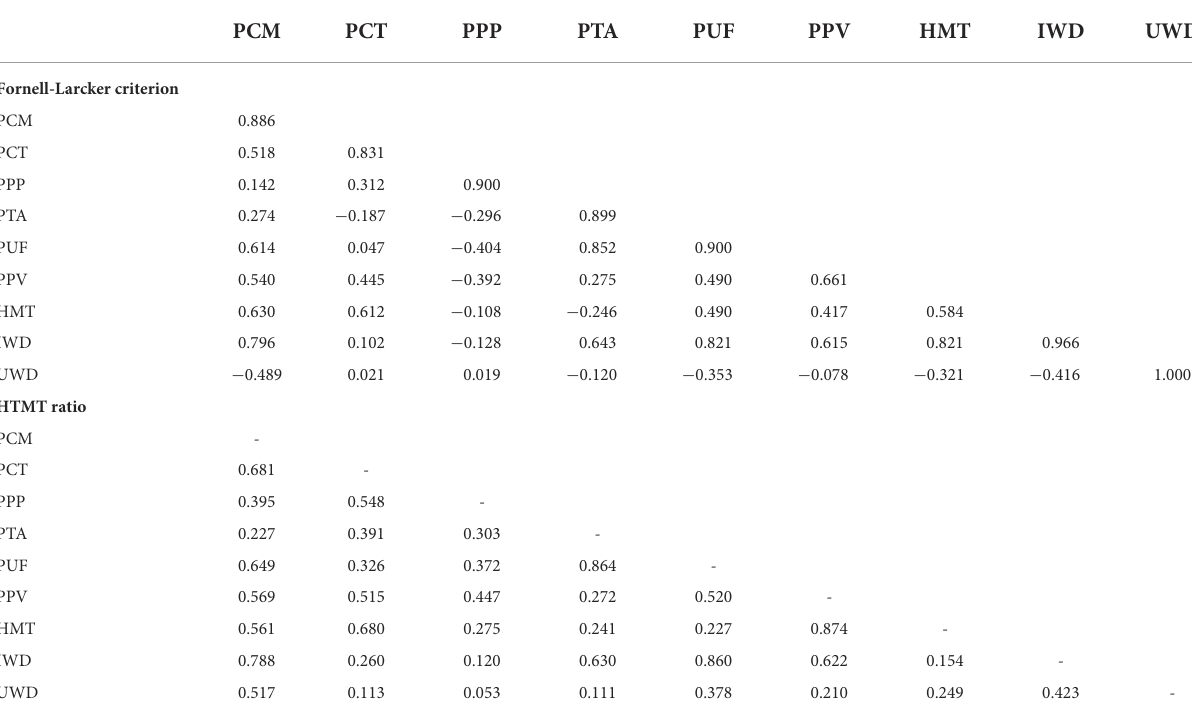
TABLE 3 Discriminant